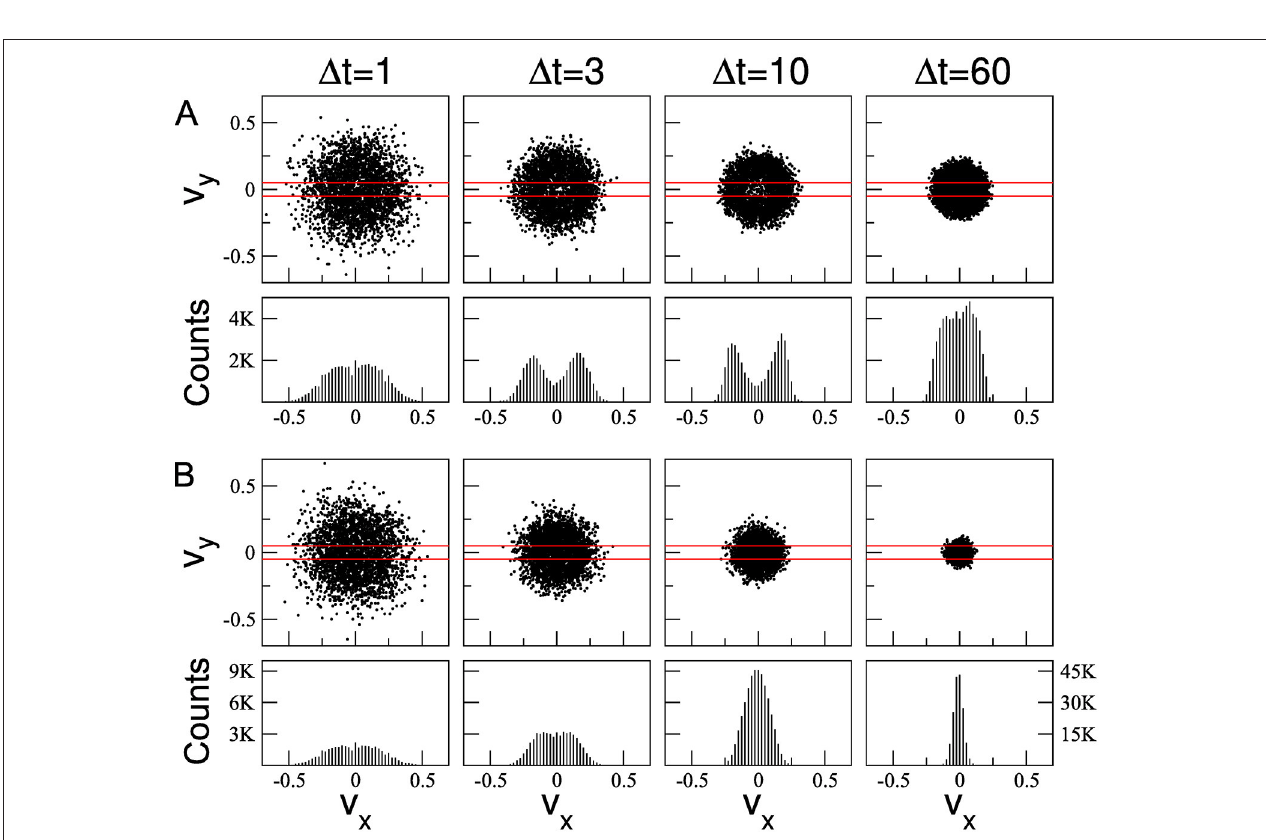
FIGURE 4 | Cell velocities v x vs v y calculated for different values of the time interval 1 t (upper panels). Histogram of the cell velocity component v x computed over the v y window indicated by red bars (lower panels). Two different values of densities were used: ρ = 0.2 (A) and ρ = 0.9 (B) . All other parameters are equal to Figure 2 .